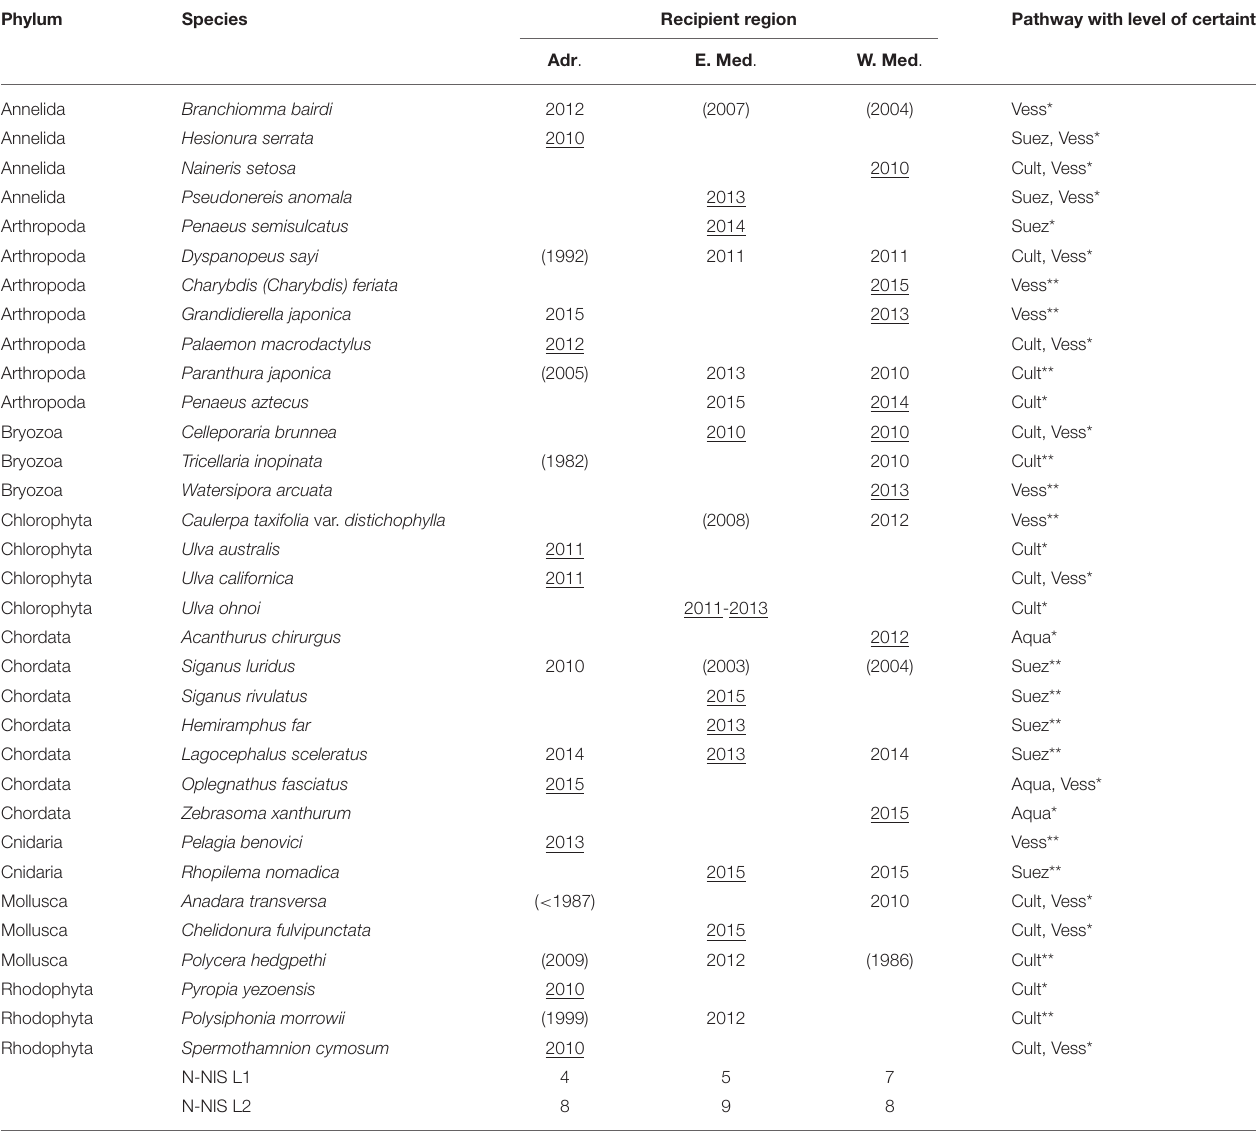
TABLE 4 | New arrivals of non-indigenous species to Italian coastal seas (Adr., Adriatic Sea; E. Med., Eastern Mediterranean; W. Med., Western Mediterranean) since 2010. Phylum Species Recipient region Pathway with level of certainty Adr